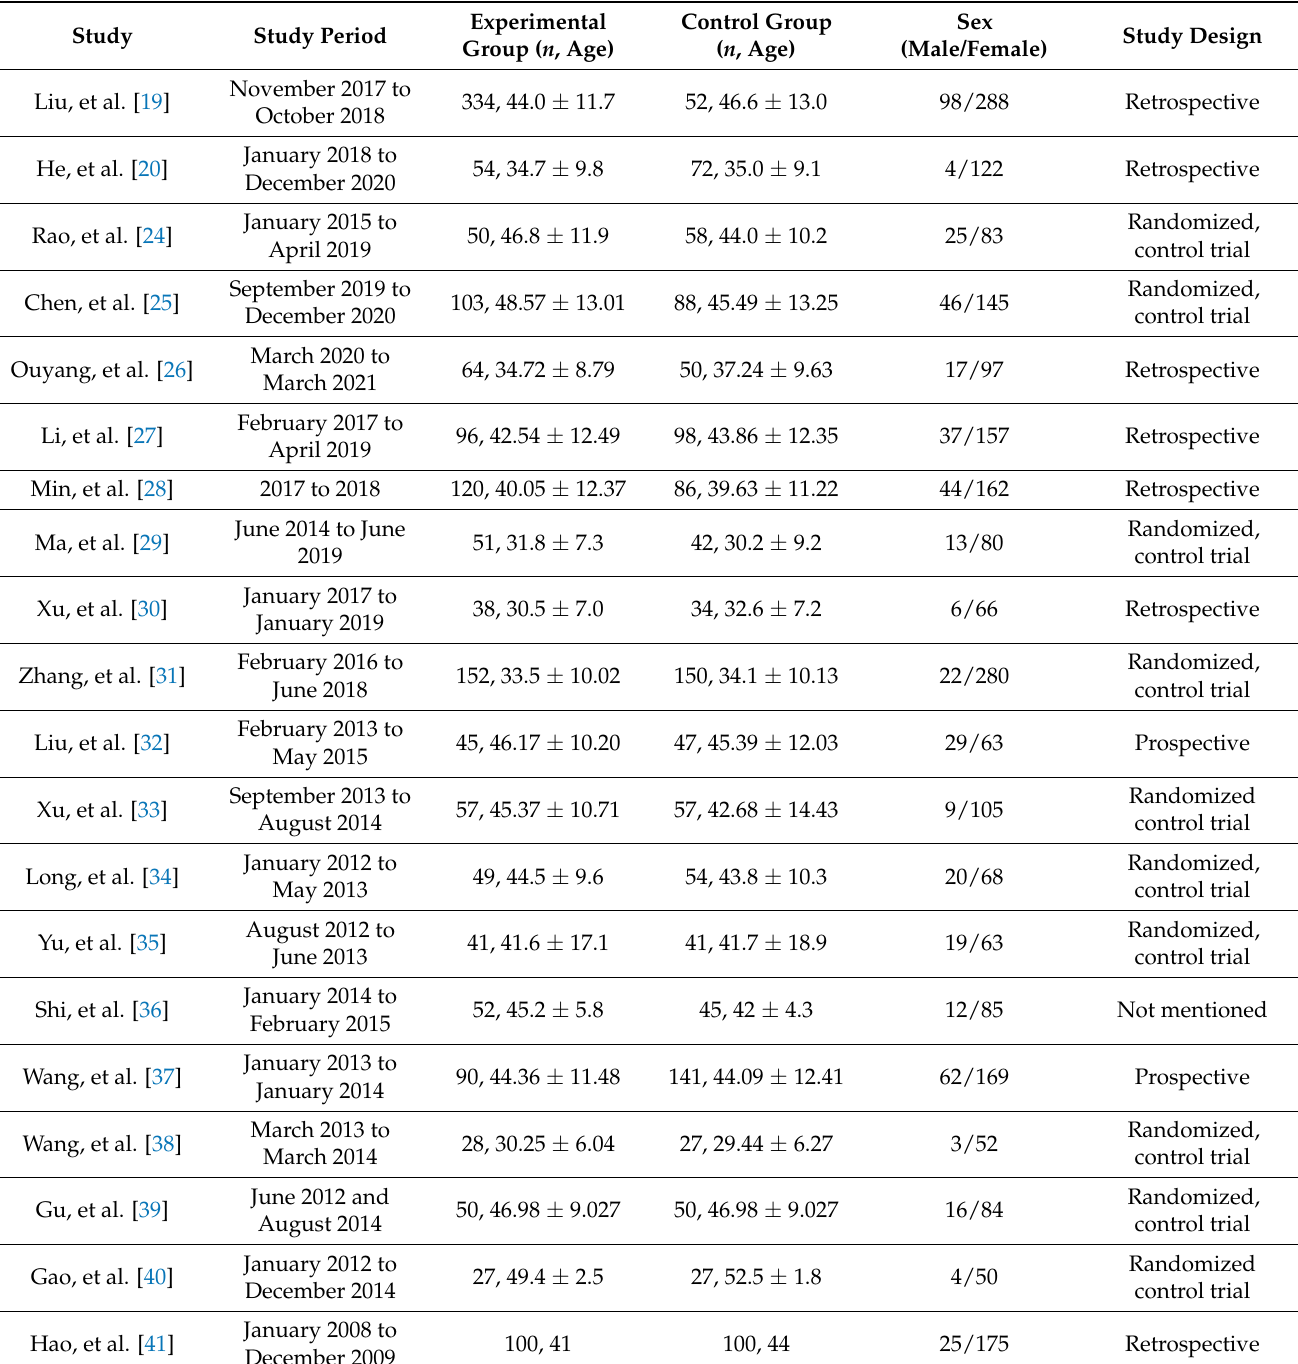
Table 1. Characteristics of each individual study included in the meta-analysis (all studies originate from